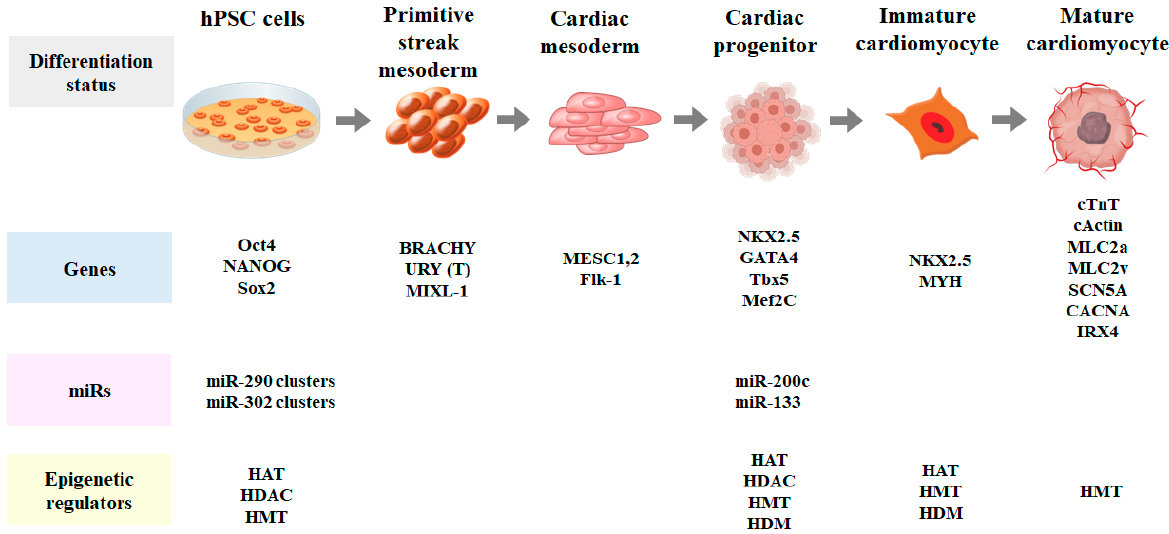
Figure 2. Differentiation of pluripotent stem cells (PSCs) into cardiomyocytes according to stage-specific gene expression and epigenetic regulation.